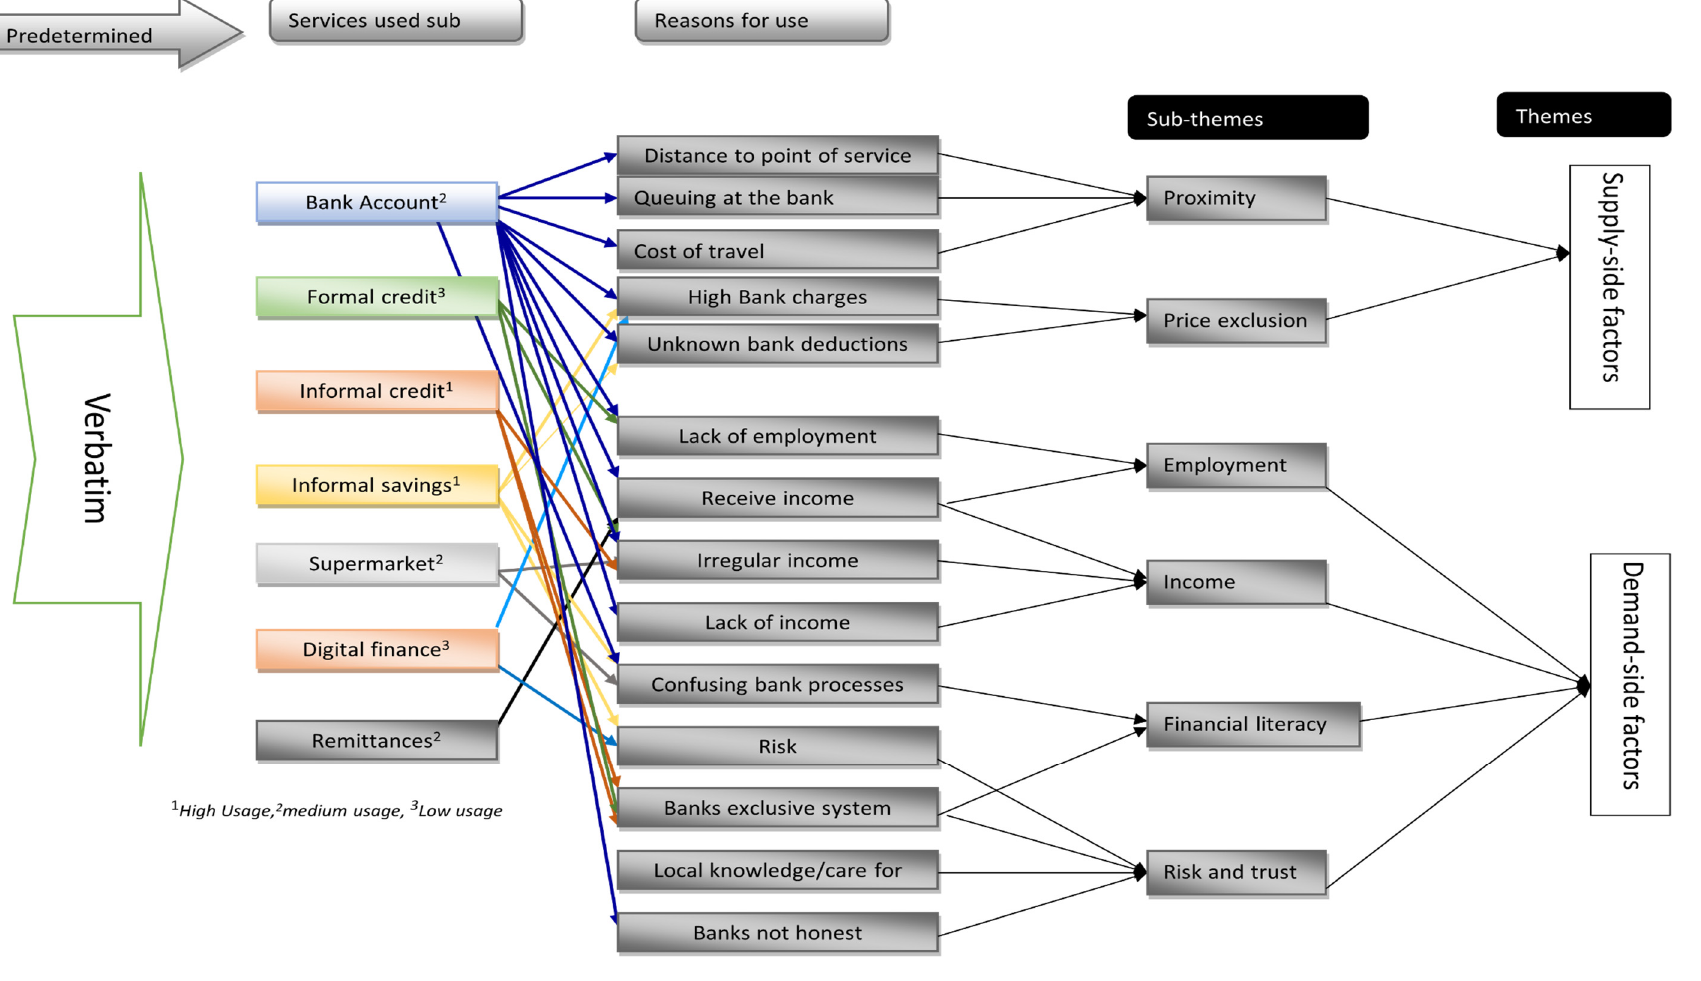
Figure 8. Process of data analysis. Figure 7. Process of data